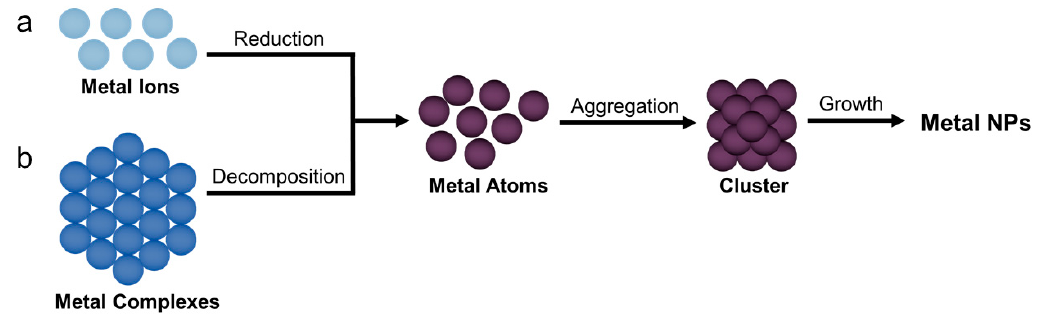
Figure 6. Reduction pathway ( a ) and decomposition pathway ( b ) for the formation of metal nanoparticles by chemical methods.